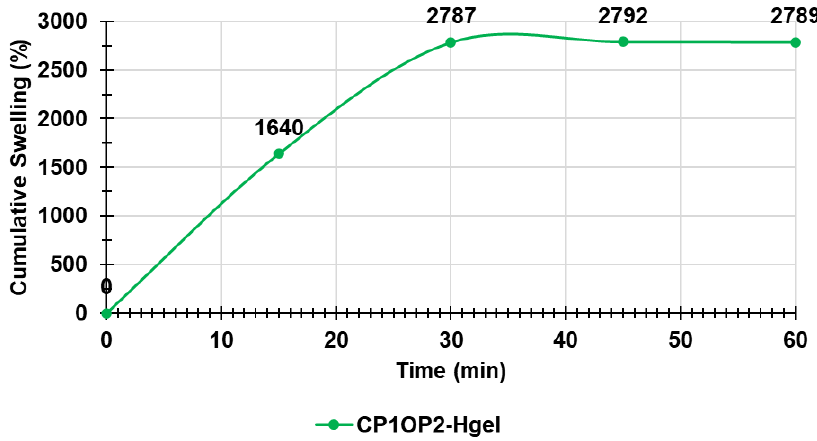
Figure 10. Cumulative swelling ratio percentage curve of CP1OP2-Hgel.